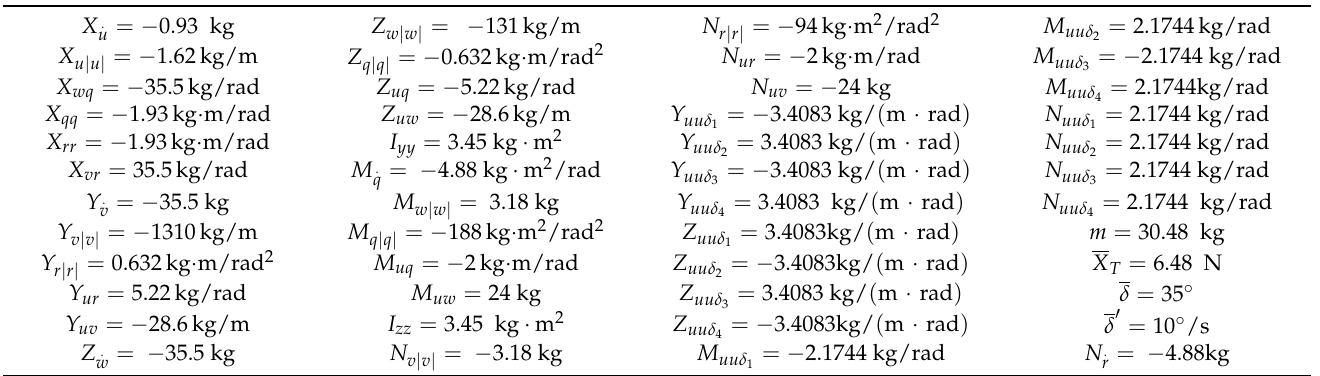
Table 2. The main parameters of the XAUV